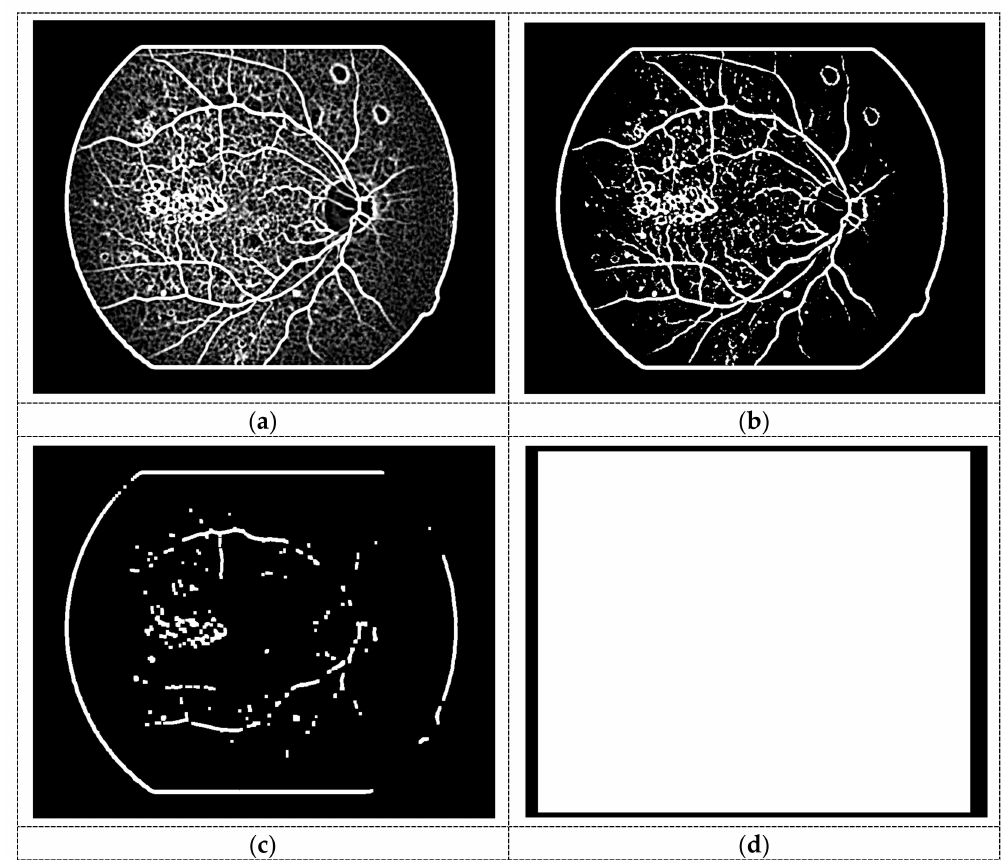
Figure 5. Illustration of candidate extraction, ( a ) results of matched filter, ( b ) result of minimum local cross-entropy thresholding, ( c ) result of morphological opening, ( d ) search region for